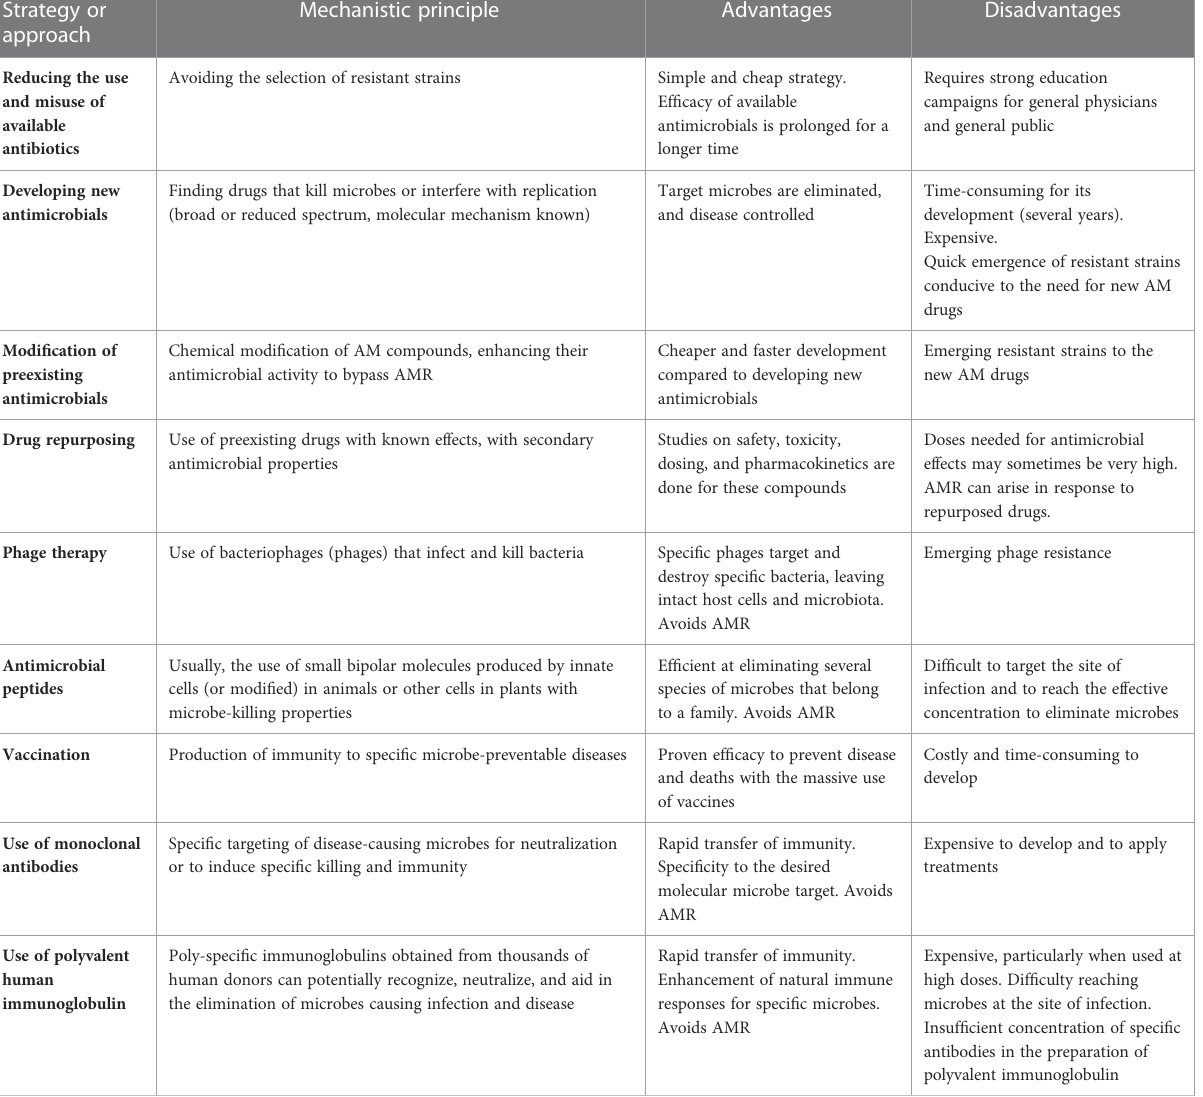
TABLE 2 Strategies to solve the challenge of